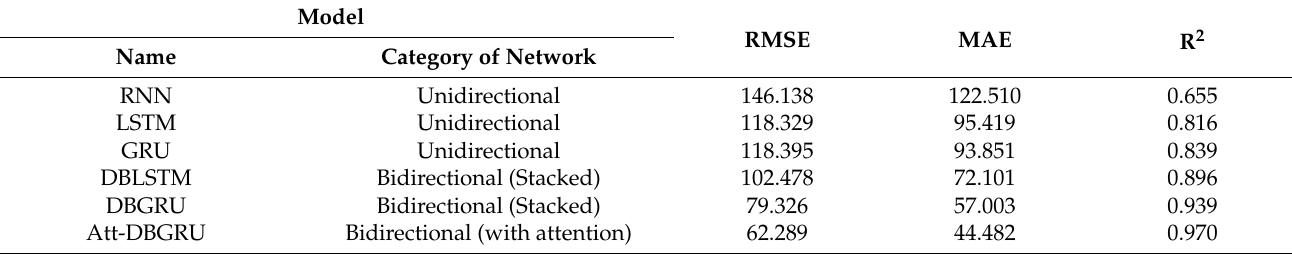
Table 1. Results of the performance evaluations (Taiyangdao